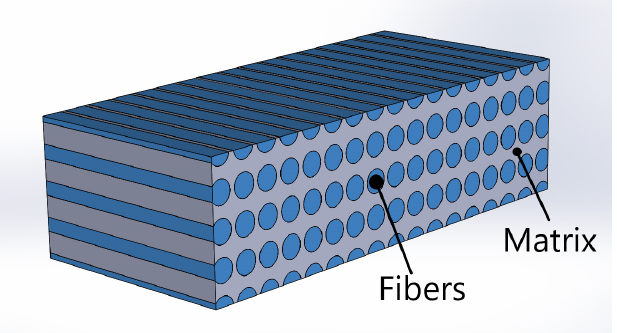
Figure 1. Schematic representation of a unidirectional fiber-reinforced